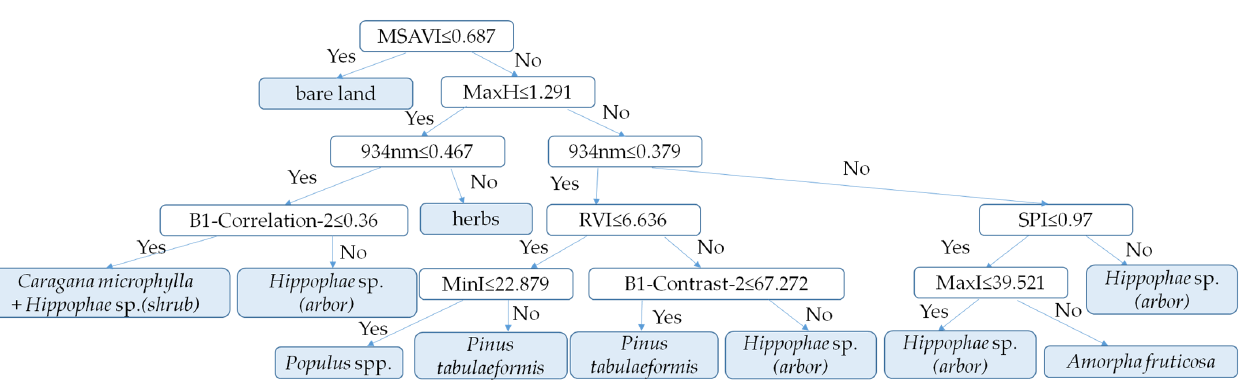
Figure 16. ( a ) Canopy heights of trees, shrubs, herbs, and bare land in study area; ( b ) cross-sectional view of single tree segmentation result; ( c ) three-dimensional models of different vegetation species compositions. Based on LiDAR and hyperspectral data, the height, intensity, echo, spectral, vege- tation index, and texture features of vegetation were extracted, and the classification re- sults of the vegetation species compositions are shown in Figure 17.